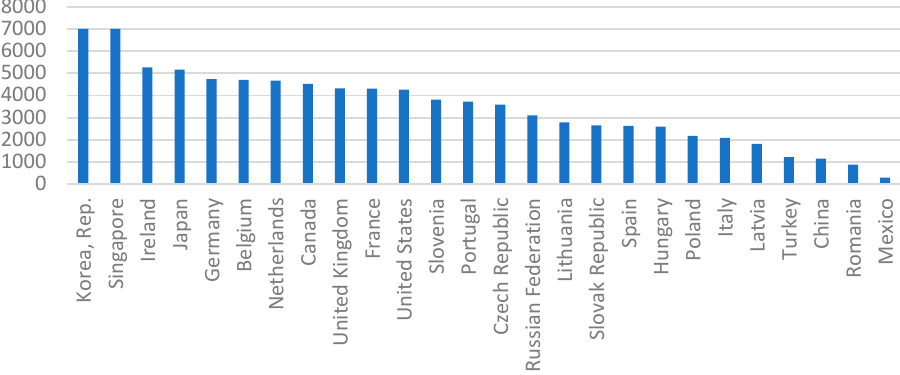
Figure 2. Researchers engaged in R&D in 2015 (per million population).